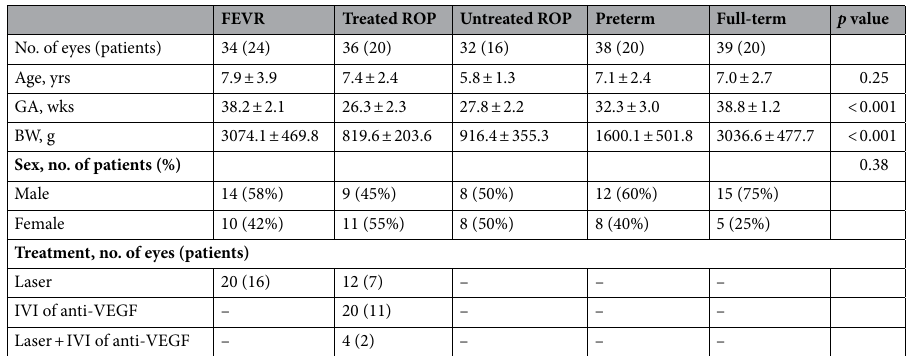
Table 1. Patient demographics in the different study groups. FEVR: familial exudative vitreoretinopathy; ROP: retinopathy of prematurity; GA: gestational age; BW: birth weight; IVI: intravitreal injection; VEGF: vascular endothelial growth factor.